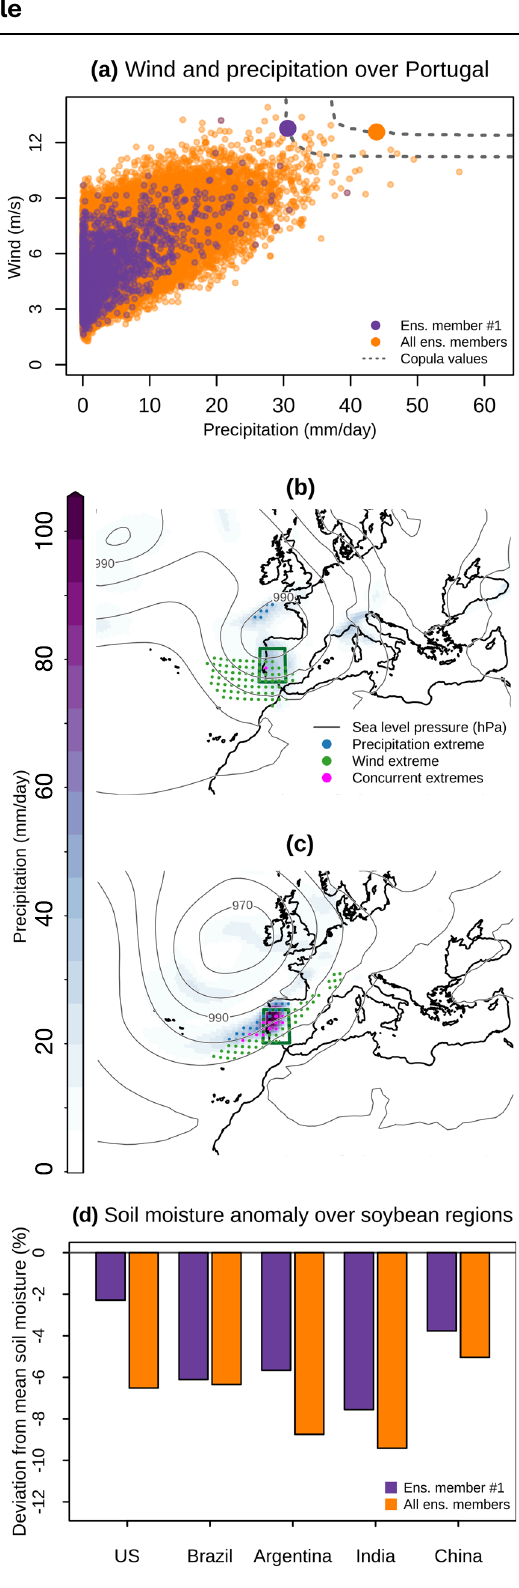
Fig. 7 | Identifying extreme event-based storylines. a Pairs of wintertime (December-February, 1950 – 1980) daily-mean precipitation and wind values aver- agedoverPortugal(boxin b , c )basedondataofthe fi rstensemblemember(violet) and based on all pooled ensemble members (orange) of the CESM1-CAM5 model. Largedotsindicatethemostextremecompoundeventsinthetwodatasets,i.e.the selected event-based storylines (Methods). b , c Precipitation (shading) and sea level pressure (isolines) associated with the selected extreme events based on one ( b ) andall ensemblemembers ( c ). Stippling indicateslocations exhibiting extreme precipitation (blue), extreme wind (green), and concurrent extremes (magenta), where extremes are de fi ned as values exceeding the local 10-year return levels — based on December – February data. d Anomalies (%, with respect to the mean; 1950 – 1980) of annual regionally averaged soil moisture over the fi ve soybean breadbasket regions according to the most extreme compound event storyline based on data from the fi rst ensemble member (violet) and based on all pooled ensemble members (orange) of the MPI-GE